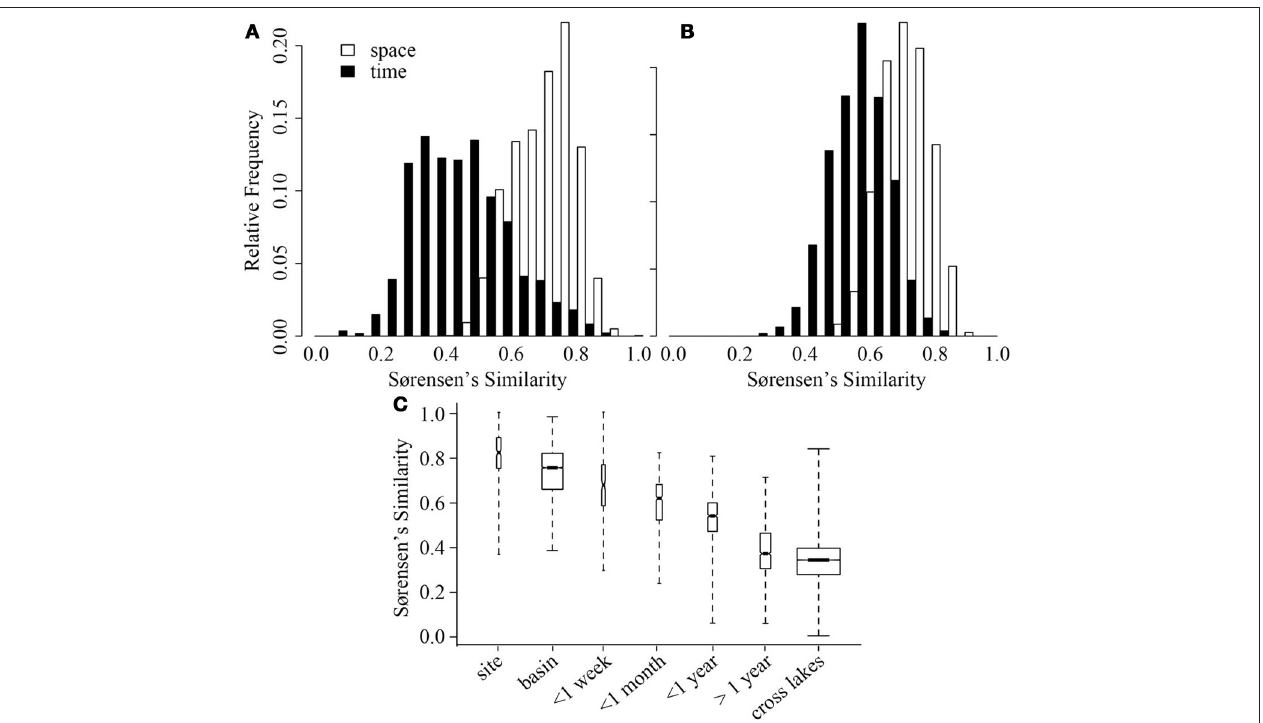
FIGURE 3 | Distributionof Sørensen’ssimilarityindicesforsamplesfrom Crystal Bog (A)andLakeMendota(B) distributedspatiallywithinthe lake (openbars) andthrough time (blackbars). Comparisonsacrossspacewere conductedusingthe32samplescollectedonasingle dayfromeach lake. Comparisonsacrosstimewereconductedusing68samplesfromCBcollected in 2003,2005,and2007(previouslyunpublished),and46samplesfromME